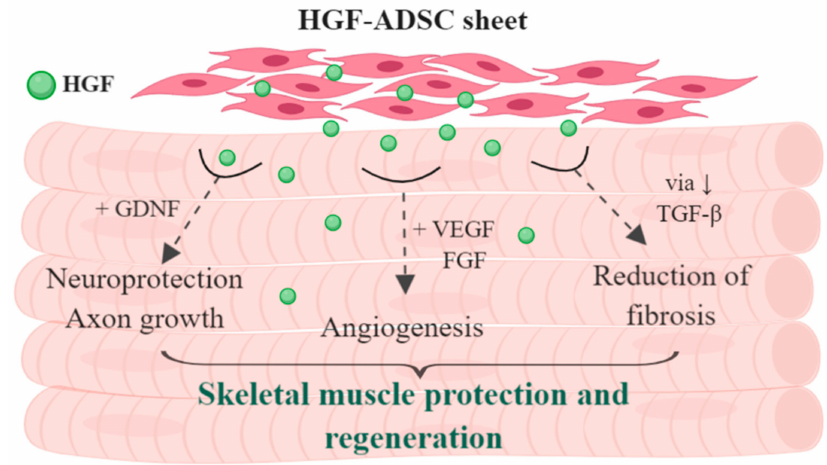
Figure 7. Schematic presentation of supposed pleiotropic e ff ect of HGF-producing ADSC sheet on skeletal muscle